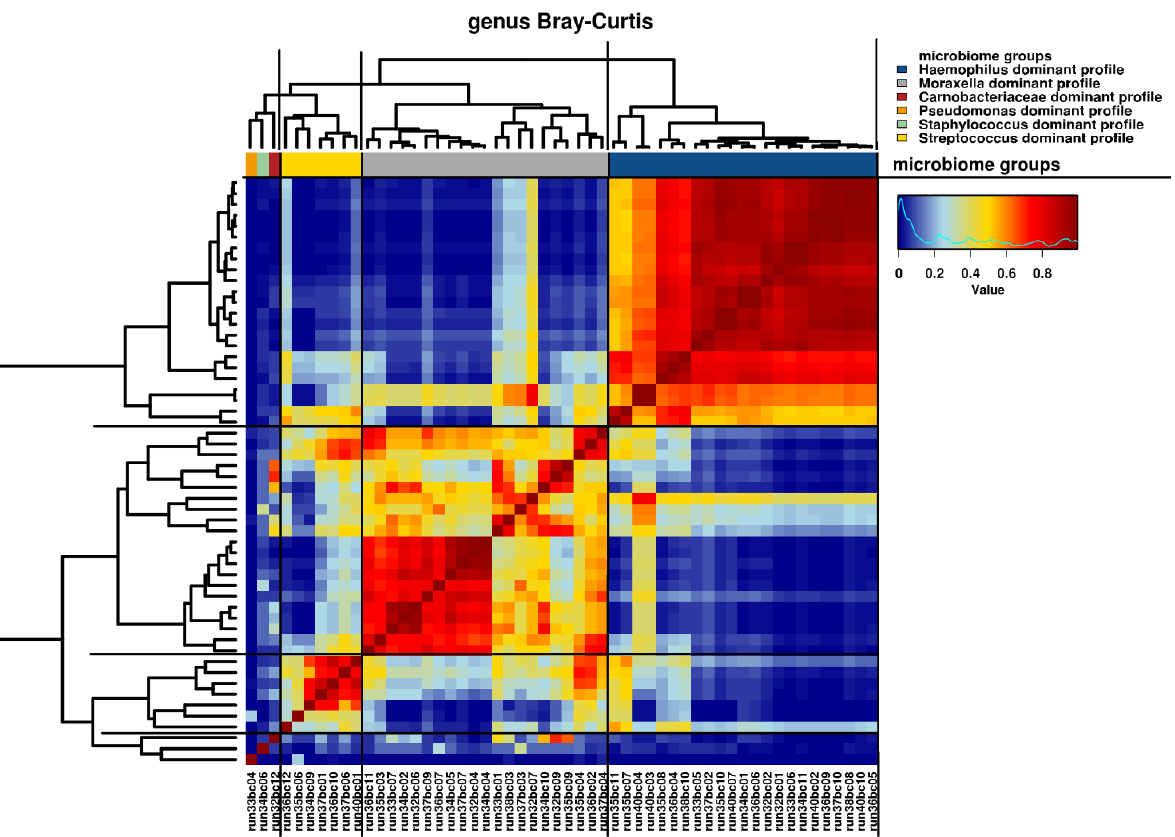
Figure 1. Hierarchical clustering of microbiome samples. Visual representation of hierarchical clustering of microbiome samples at the genus level with the Bray–Curtis distance metric. A heat map is shown, characterized by similarity values ranging from 0 to 1. Samples are presented as run numbers. A dendrogram of the hierarchical clustering is shown with distances represented by the length of the individual branches. Genus dominant profiles are presented by colored bars, as indicated by the accompanying figure legend.